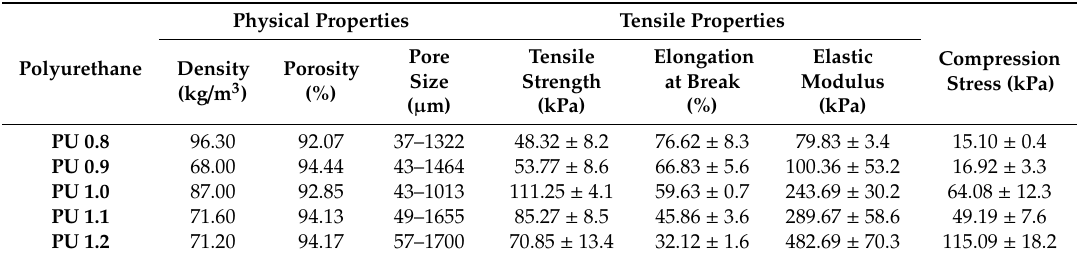
Table 3. Physical and mechanical properties of polyurethanes produced by di ff erent isocyanate indices (Mean ± SD, n =